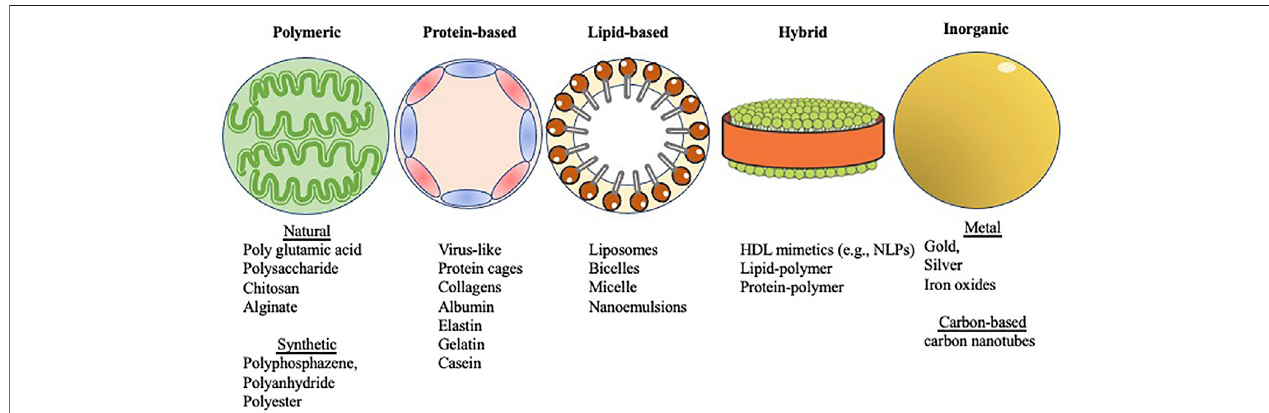
FIGURE 1 | Shown in abstract form are fi ve different types of nanoparticles covered within this review. The categories were selected based on the major constituents that form the different nanoparticles (see Section 3 text). Images were adapted from Servier Medical Art by Servier, which is licensed under a Creative